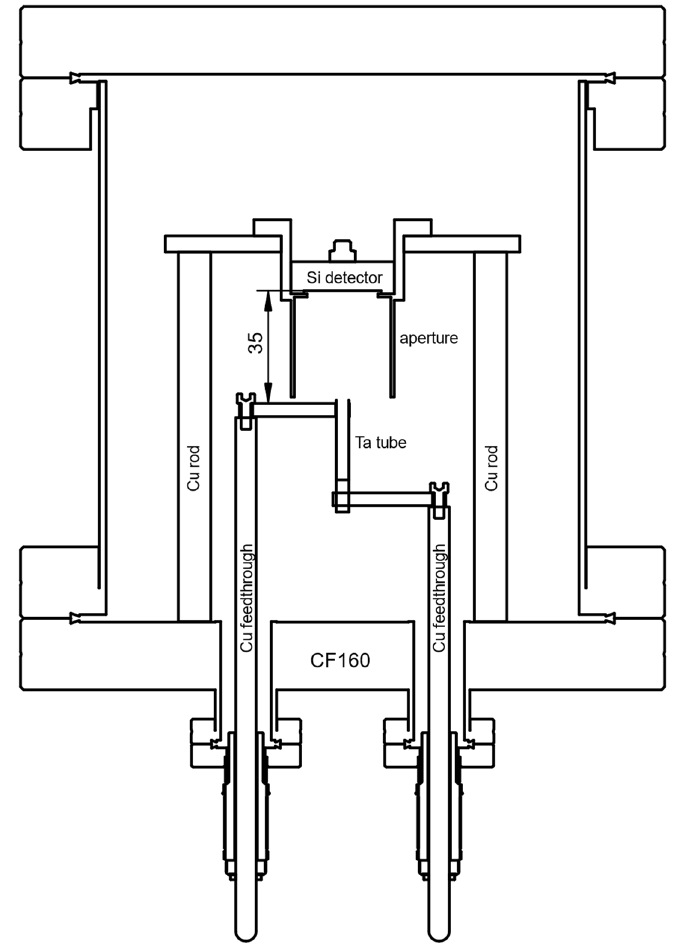
Figure 2. Schematic drawing of the custom thermal-PVD setup used in this work. Drawing not to scale. Details of the setup are described in Section 2.1.